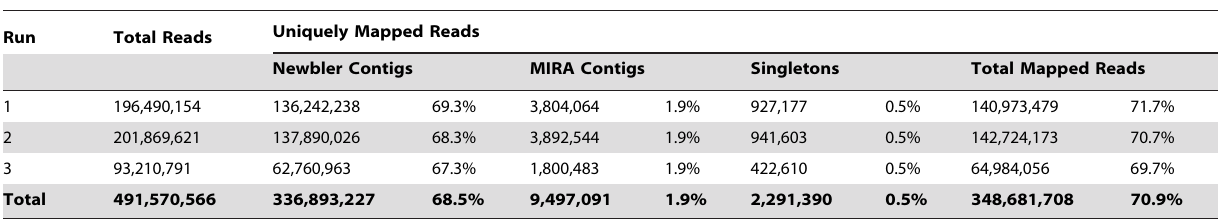
Table 1. Summary of sequencing and mapping